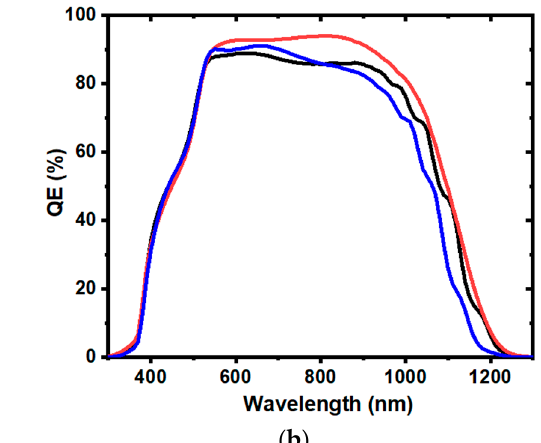
Figure 4. Representative J-V ( a ) and QE ( b ) curves for reference (black), second stage LT (red) and second stage HT (blue) Figure 3. Secondary Ions Mass Spectroscopy (SIMS) depth profile (positive ions) of the main elements for the reference devices. Table 3. Photovoltaic characteristics and diode parameters of the representative cells shown in Figure 4.